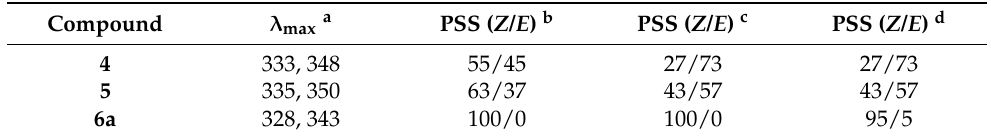
Table 1. Absorption spectra and photostationary state (PSS) in different irradiation